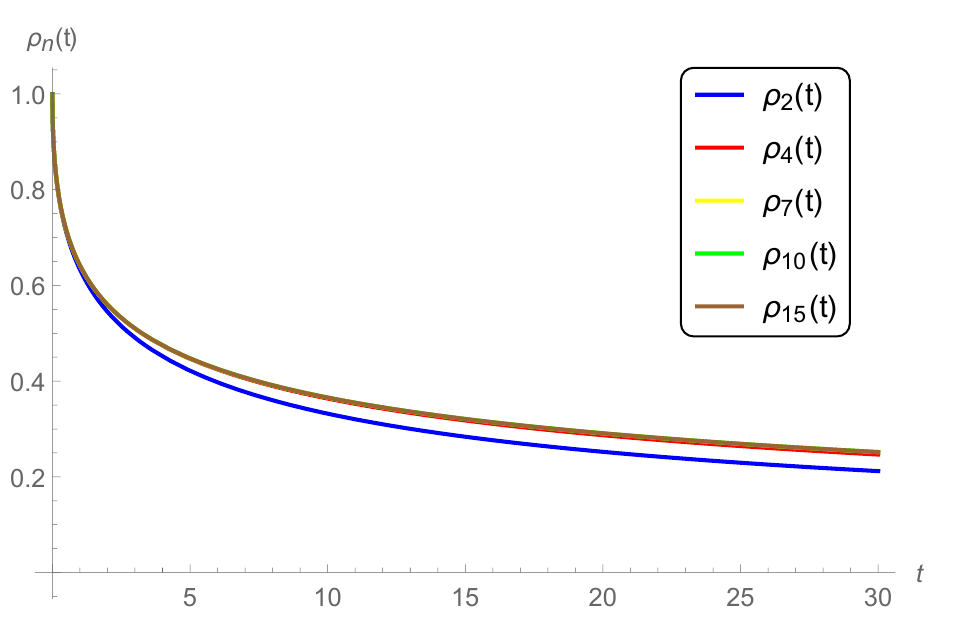
Figure 4. Graphs of the n -th approximate solution of (11), (12) with n = 2,4,7,10,15 and λ = 1, α = 0.5, and q = 2.